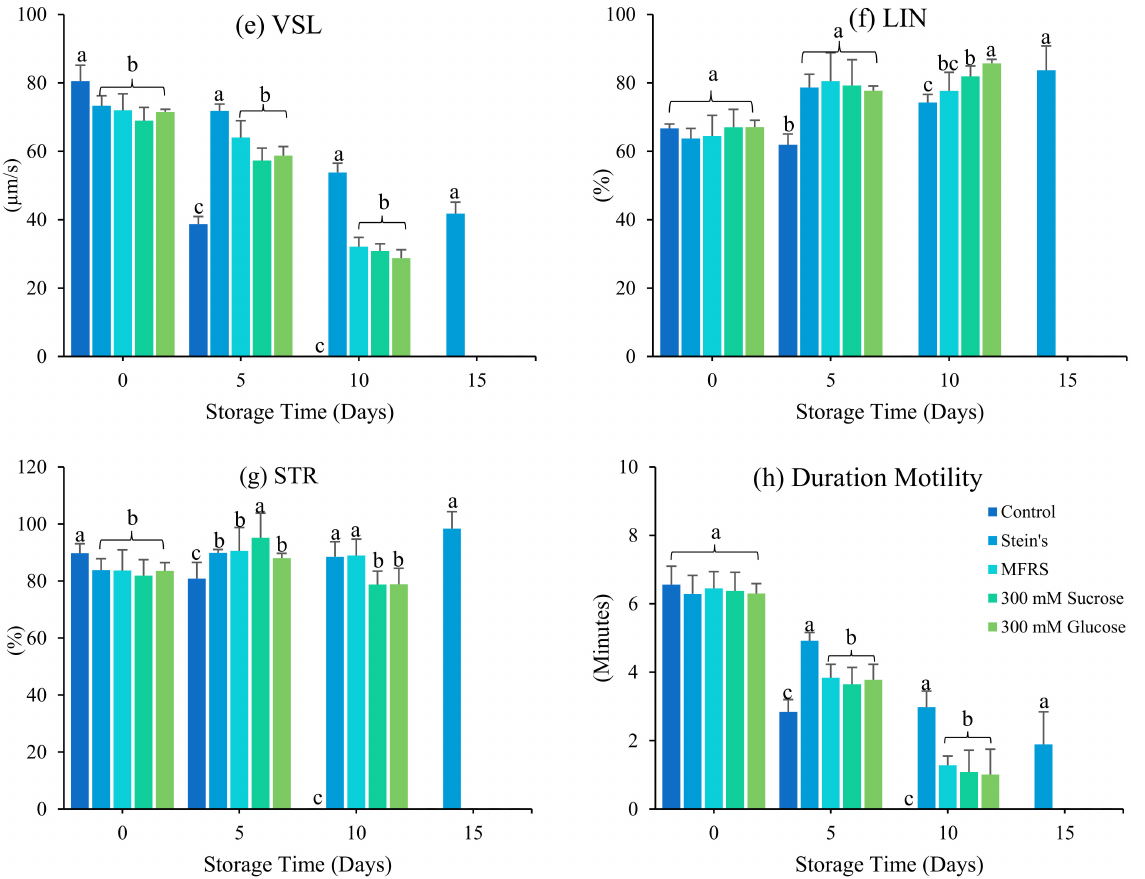
Figure 1. Effects of diluents on sperm of spotted halibut ( Verasper variegatus ) stored for 15 days at 4 ◦ C.